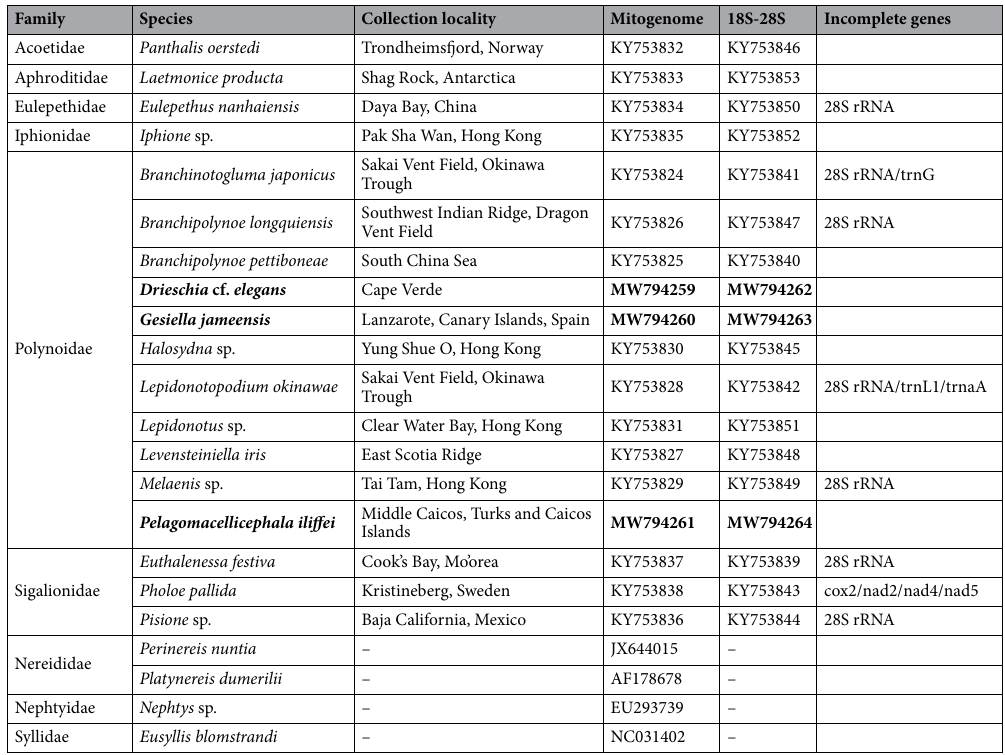
Table 4. List of all taxa used for this study, including collection locality and GenBank accession numbers. Newly sequenced taxa are in